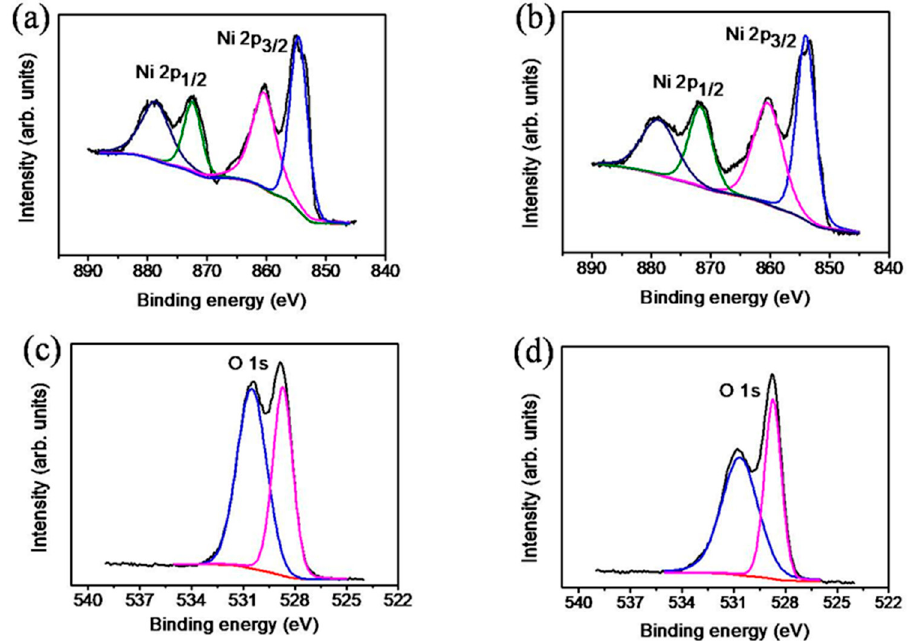
Figure 4. High-resolution XPS spectra in Ni 2p region of TiO 2 –NiO composites formed at various temperatures: ( a ) 350 °C and ( b ) 500 °C. High-resolution XPS spectra in O 1s region of TiO 2 –NiO composites formed at various temperatures: ( c ) 350 °C and ( d ) 500 °C.